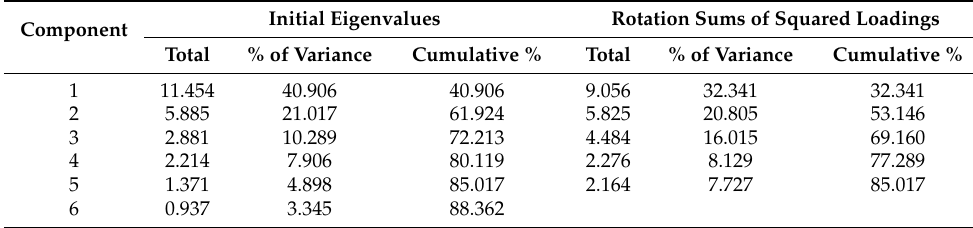
Table 2. Total variance explained.